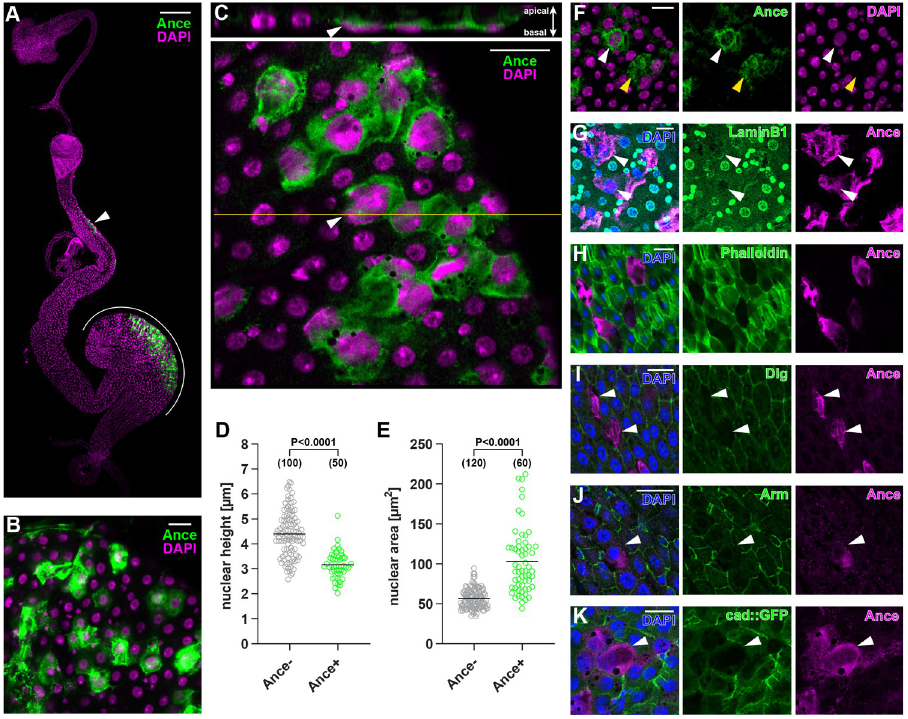
Fig 1. An Ance+ enterocyte subpopulation exhibits unique features. (A) Cells in R2 (arrowhead) and R4 (white line) express Ance. ( B) An enterocyte subpopulation displays Ance protein. ( C) Nuclei of Ance+ cells (arrowhead) are flattened and lie in close apposition to the basal, visceral muscle. ( D - E) Quantification of nuclear height (D) and nuclear area (E). ( F) Some Ance+ enterocytes show weak (white arrowhead) or absent (yellow arrowhead) genome staining by DAPI. ( G) Immunostaining of nuclear LaminB1 is reduced in Ance+ enterocytes (arrowheads). ( H) Ance + enterocytes decrease F-actin indicated by the absence of phalloidin staining. ( I-K) Ance+ enterocytes exhibit less cell adhesion components. Immunostaining for Dlg labeling septate junctions (I) and β -catenin/Arm labeling adherens junctions (J) was reduced in Ance+ cells (arrowheads). Likewise, cadherin GFP knock-in flies demonstrate less adherens junctions in Ance+ enterocytes (arrowhead) (K). Statistical significance was determined by using a two-tailed unpaired t test (D and E). S1 Data provides the source data used for all graphs and statistical analyses. Scale